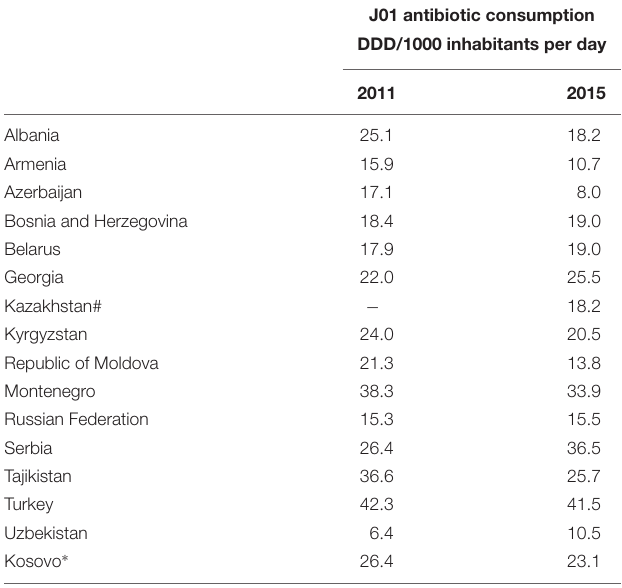
TABLE 1 | Total antibiotic consumption 2011, 2015 in DDD/1000 inhabitants per day.